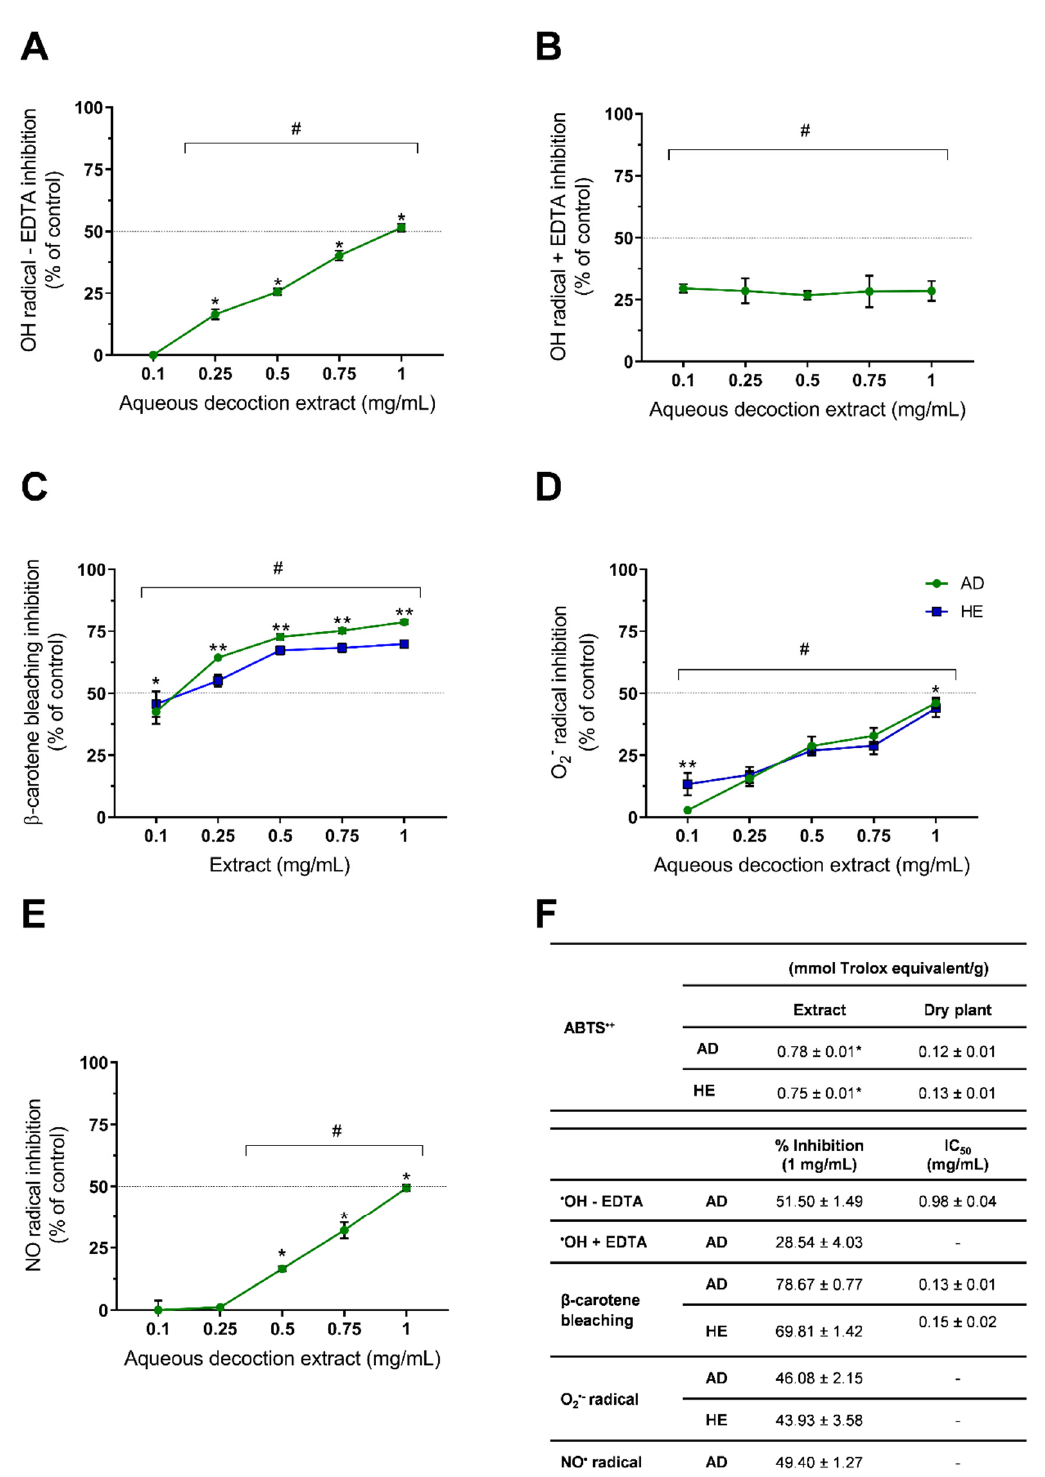
Figure 2. In vitro evaluation of T. capitellatus antioxidant activity. Hydroxyl radical scavenging ( A , B ), β -carotene bleaching ( C ), superoxide radical scavenging ( D ), nitric oxide radical scavenging ( E ) and respective inhibitions at 1 mg/mL and IC 50 ( F ). Results are presented as % of radical inhibition (% of the control). Significant statistical differences are marked as (#) when compared to the control, (*) when compared with the previous and following concentration, and (**) between extracts at the same concentration, when p < 0.05, demonstrated by using Tukey’s post hoc test. Results are presented as mean ± standard deviation ( n = 3).